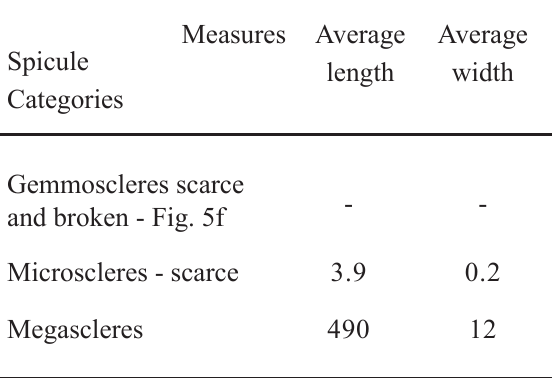
Category and measures (µm) of spicules of M. spinata detected in the three studied